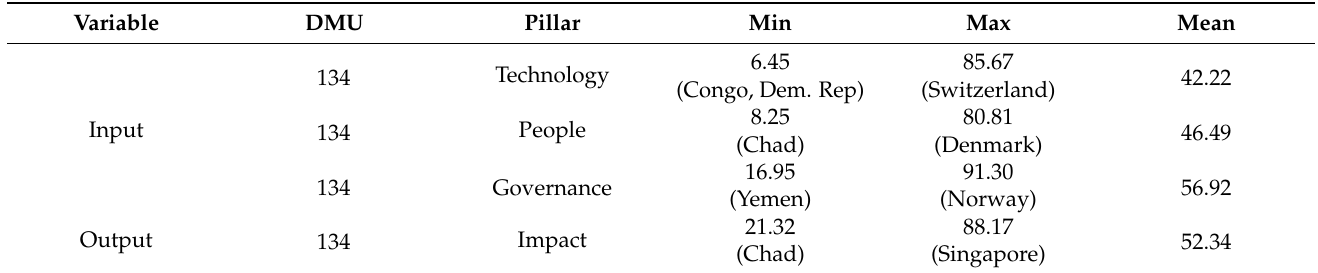
Table 3. Descriptive statistics of input and output